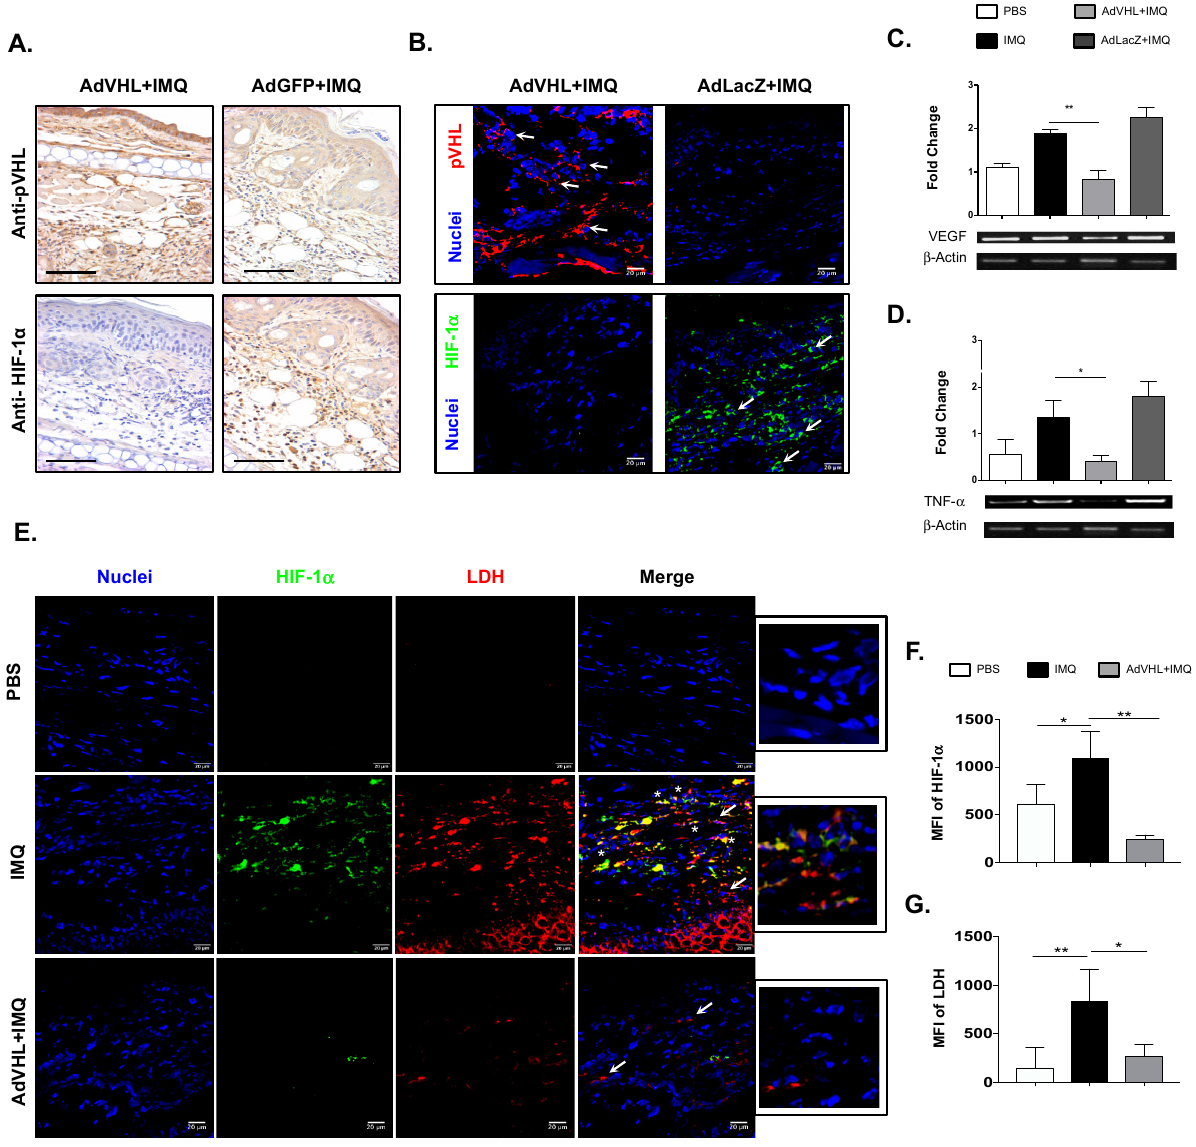
Figure 4. Negative regulation of HIF-1 α and its downstream mediators mediated by pVHL expression in psoriatic skin. Immunohistochemistry of mouse ear skin treated with IMQ in the presence of AdVHL or AdGFP. Representative images from lesional skin sections for the detection of: ( A ) pVHL and HIF-1 α . Scale bar = 100 μ m. ( B ) Immunofluorescence images of pVHL (red), HIF-1 α (green) and nuclei (blue) from mice skin treated with AdVHL+IMQ or AdLacZ+IMQ. The images are representative of three independent experiments. RT-PCR analyses from whole lesional skin extract of mice treated with PBS, IMQ, AdVHL+IMQ or AdGFP+IMQ. ( C ) Expression of VEGF and ( D ) TNF- α . Bar graphs show data obtained from six independent experiments (two-way ANOVA with post hoc Tukey’s test), and band images are representative of one experiment. ( E ) Confocal representative images of HIF-1 α (green) and LDH (red) expression in normal and lesional skin of mice treated with PBS, IMQ or AdVHL+IMQ. Arrows indicate the cells expressing one molecule of interest, whereas asterisks indicate co-expression of HIF-1 α and LDH. Small images depict a digital magnification of the merged pictures. Bar graphs show the Mean Fluorescence In- tensity (MFI) of ( F ) HIF-1 α and ( G ) LDH expression in the three groups of mice. MFI was evaluated in eight different fields from two independent experiments. One-way ANOVA with post hoc Tukey’s test. * p < 0.05, ** p < 0.01. Ad: Adenoviral vector, IMQ: Imiquimod, pVHL: von Hip- pel-Lindau protein, HIF-1 α : Hypoxia-Inducible Factor-1 alpha, TNF- α : Tumor Necrosis Factor al- pha, VEGF: Vascular Endothelial Growth Factor.